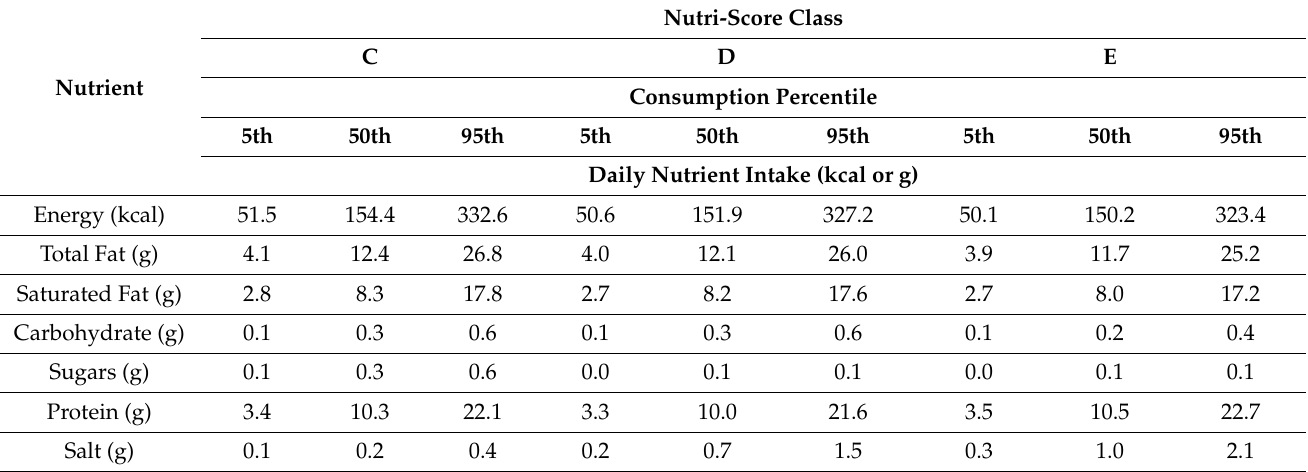
Table 5. Daily individual intakes of nutrients from the consumption of graviera cheese products classified in different Nutri-Score classes. Intakes are estimated based on the median values of nutrient contents for each class.